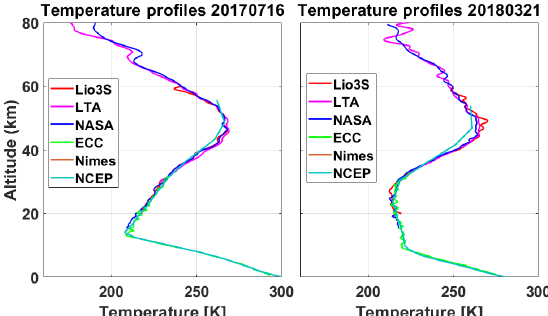
Figure 3. Temperature profiles measured by the different instru- ments at Observatoire de Haute-Provence on the nights of 14– 15 July 2017 and 22–23 March 2018. Note the seasonal differences in the character of the ozone profiles in spring and summer.